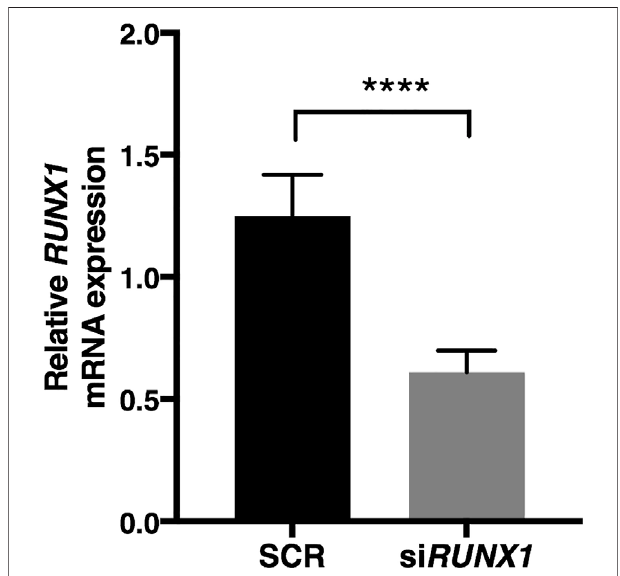
FIGURE 3 | RUNX1 expression is signi fi cantly reduced by speci fi c siRNA. RUNX1 expression was determined in DS-HFFs transfected with 20 nM si RUNX1 for 72 h. Values represent the average determination ± SEM from fi ve SCR and the fi ve corresponding RUNX1 -silenced DS-HFFs carried out in triplicate. **** p -value ≤ 0.0001.